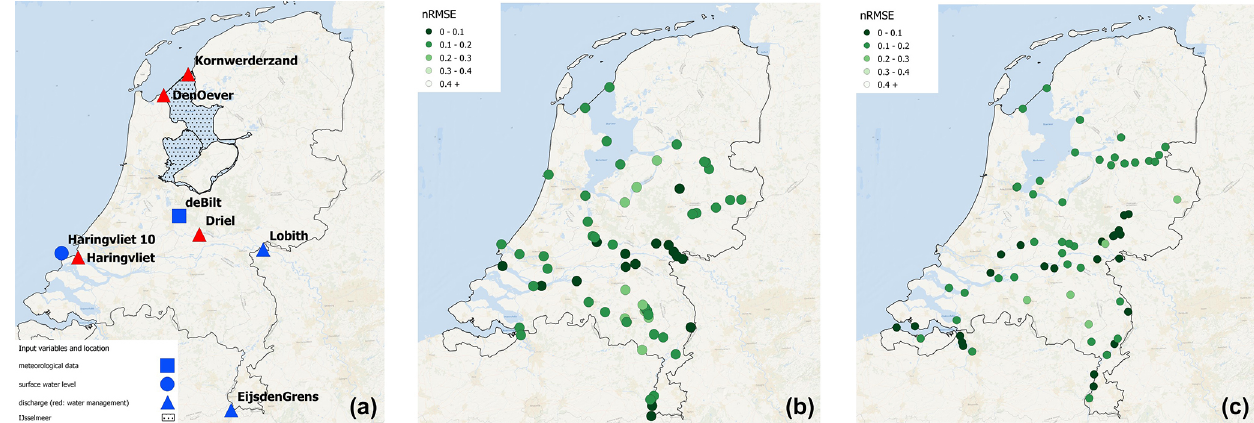
Figure A1. Overview input stations (a) for the ML model framework, the locations of discharge (b) , and surface water level (c) target stations used during model development. All figures are directly taken from Hauswirth et al. (2021). Discharge and surface water level stations include the RMSE score achieved during evaluation of the modelling framework (more details can be found in Hauswirth et al., 2021). Maps were created using QGIS (QGIS Development Team, 2022), HCMGIS plugin and basemap data from Esri Ocean (Sources: Esri, GEBCO, NOAA, National Geographic, DeLorme, HERE, https://www.geonames.org (last access: March 2021), and other contributors), and the Global Administrative Areas (GADM) database.